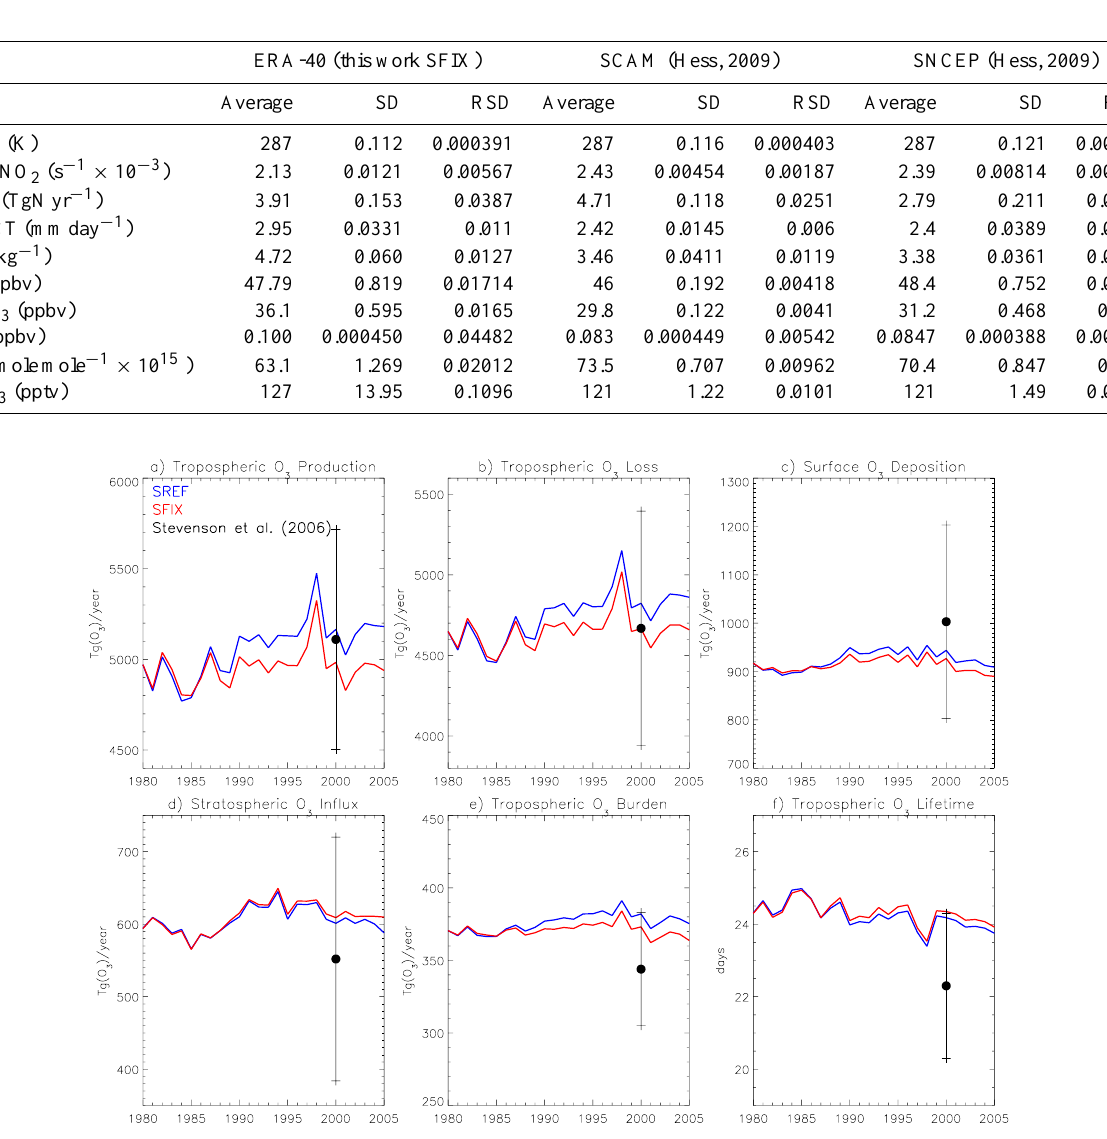
Fig. 9. Global tropospheric O 3 budget calculated for the period 1980–2005 for the SREF (blue) and SFIX (red) ECHAM5-HAMMOZ simulations: (a) chemical production ( P ); (b) chemical loss ( L ); (c) surface deposition ( D ); (d) stratospheric influx ( S inf = L + D − P ); (e) = B + D )). The black points for the year 2000 represent the mean ± standard deviation tropospheric burden ( B O ); (f) lifetime ( τ O O 3 /( L 3 3 budgets as found in the multi model study of Stevenson et al.